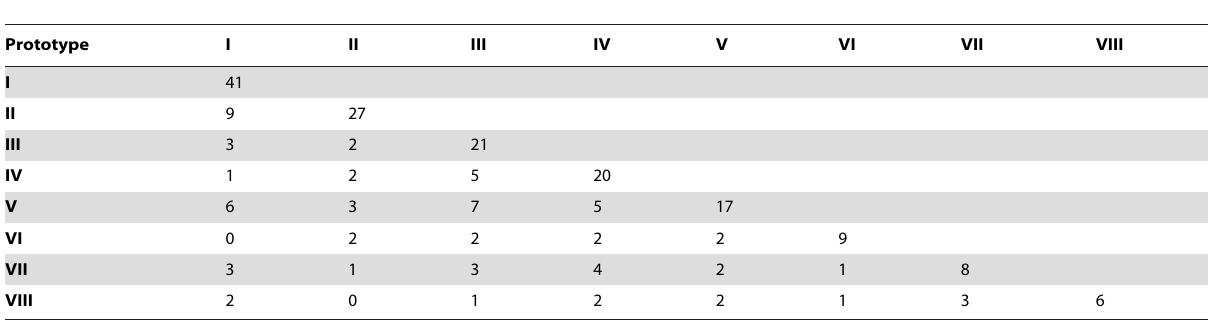
Table 2. Redundant SG recognition by distinct